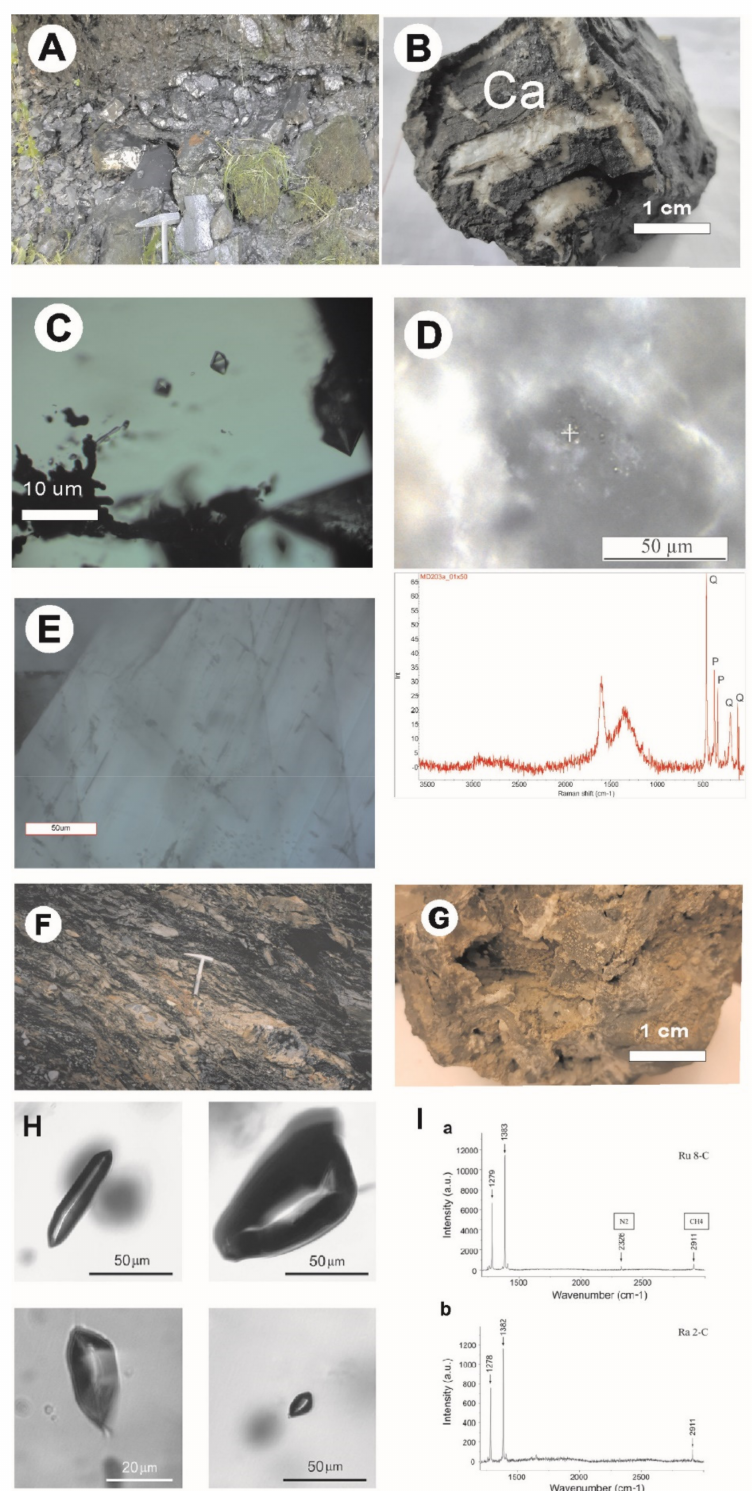
Figure 3. The occurrence of the tectonic m é lange in the field and mineralogical samples in MD and JRC areas. ( A ) The outcrop in the Mszana Dolna region; ( B ) Calcite veins sampled; ( C ) Methane inclusions in quartz; ( D ) Image and Raman spectrum of assemblage of quartz (Q), organic matter and pyrite (P); ( E ) Fluid inclusions in calcite; ( F ) The outcrop in the wall of the Jabłonki stream (JRC area); ( G ) Assemblage of sampled calcite (Ca) and quartz (Q); ( H ) One phase gas-filled inclusions in quartz; ( I ) Raman spectra showing presence of methane and nitrogen in inclusions. (a) Ru 8-C, (b) Ra